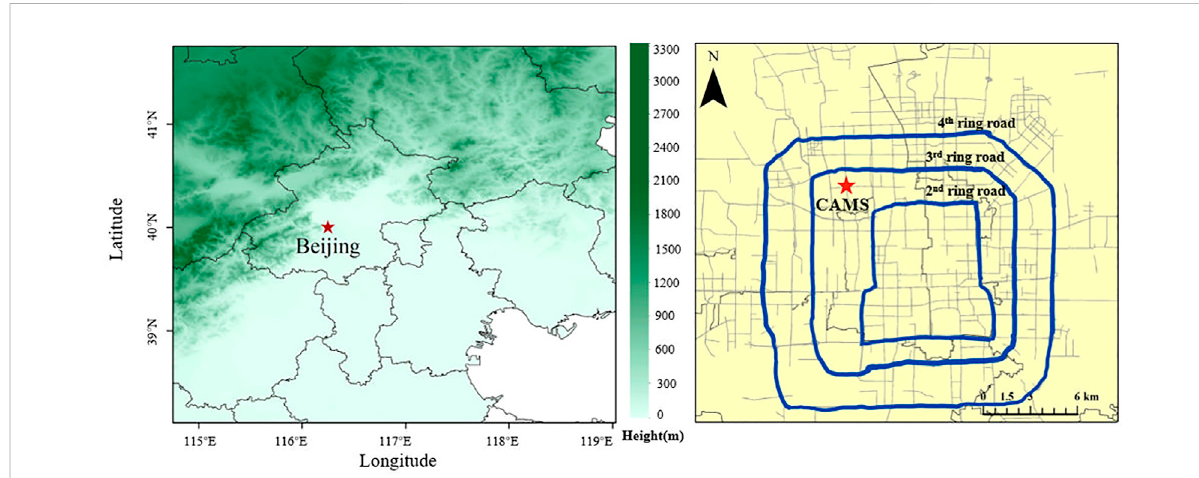
FIGURE 1 Geographical location of the observation site. The blue lines represent Beijing ’ s main ring